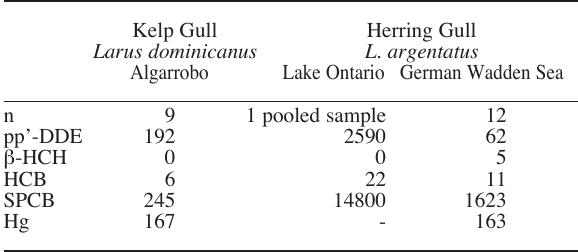
T ABLE 3. – Comparison of egg contamination (ng/g, arithmetic means) of Kelp Gulls in Chile and Herring Gulls in North America (Weseloh pers. comm.) and Europa (Muñoz and Becker unpubl. data) in